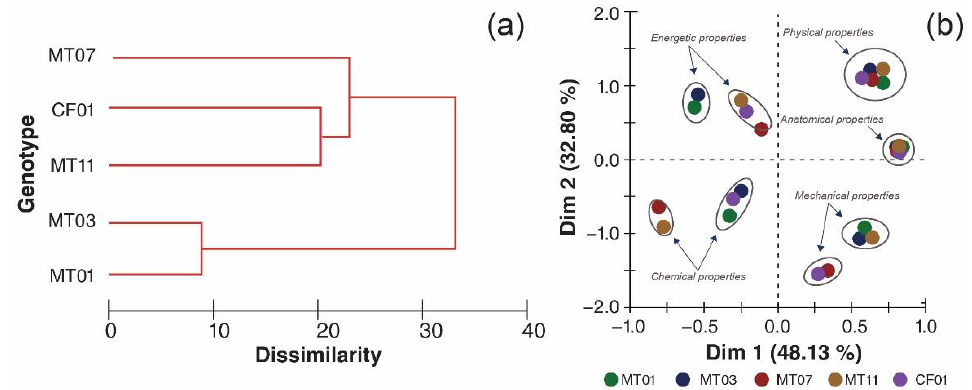
Figure 5. Cluster analysis ( a ); similarity clustering ( b ) of the fiber properties of five genotypes of M. textilis .